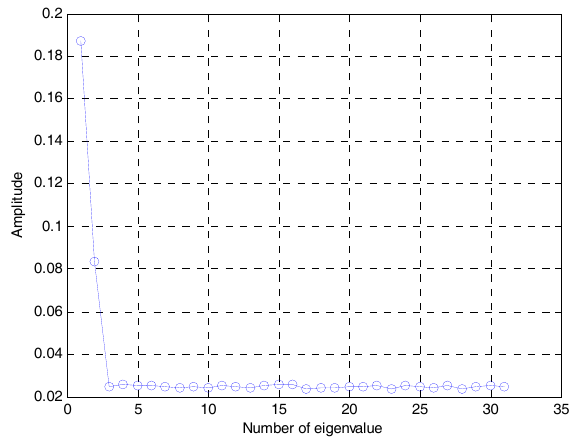
Figure 3. The estimated eigenvalues of the autocorrelation matrix of the DSSS signal.